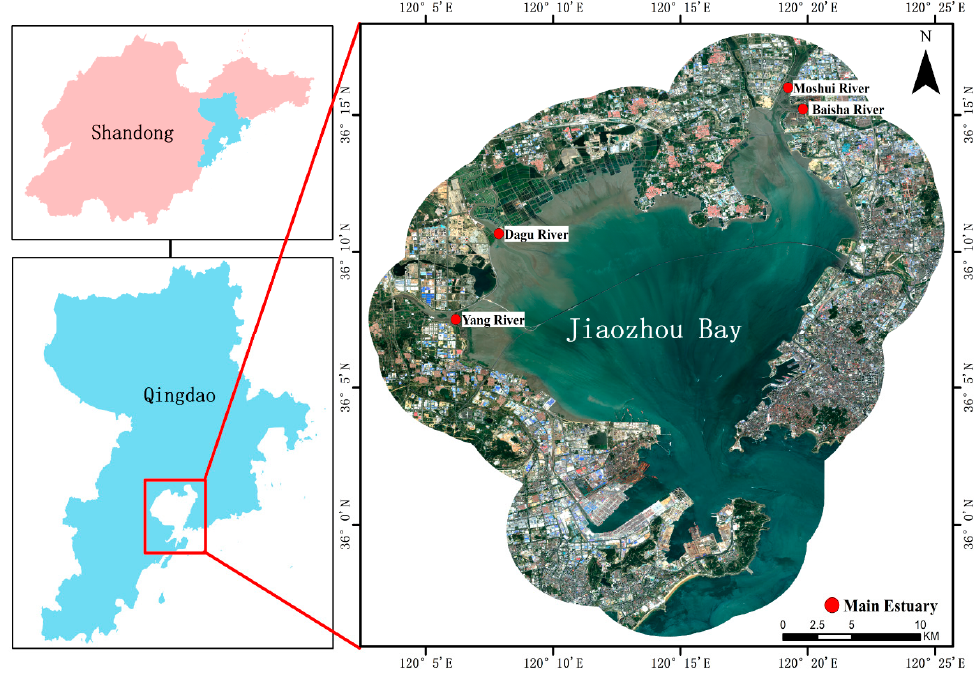
Figure 1. Location of the study area and remote sensing image (GF-2).